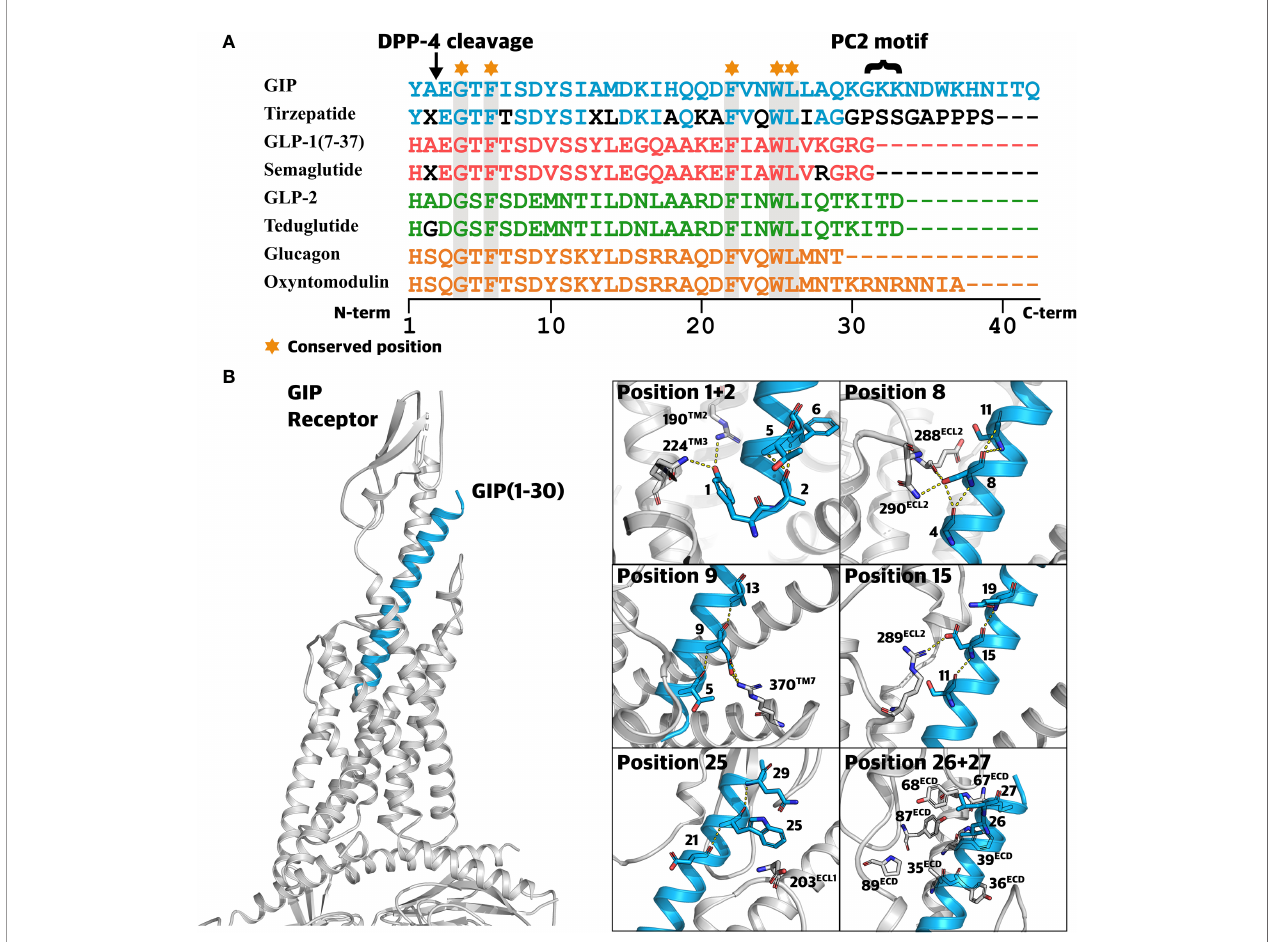
FIGURE 5 | Class B1 ligands and the structural perspective. (A) Sequence alignment of related class B1 ligands and peptide analogs. Sequence alignment of glucose-dependent insulinotropic polypeptide (GIP), tirzepatide (dual GIPR/GLP-1R agonist), glucagon-like peptide-1 (GLP-1), semaglutide (GLP-1 analog), GLP-2, teduglutide (GLP-2 analog), glucagon, and oxyntomodulin. A ‘ X ’ denotes a -aminoisobutyric acid (Aib). Amino acids displayed by black letters represent sites deviating from those of the endogenous peptide. Conserved positions across all peptides are highlighted in grey. (B) Highlighted ligand-receptor interactions between GIP and the GIPR. 3D visualization of GIP(1-30) (blue) in complex with the GIPR (grey) and the G a s protein (grey) (Protein Data Bank: 7DTY) (57). Frames to the right display important hydrophobic interactions and polar interactions (yellow dotted lines) between GIPR (grey) and GIP